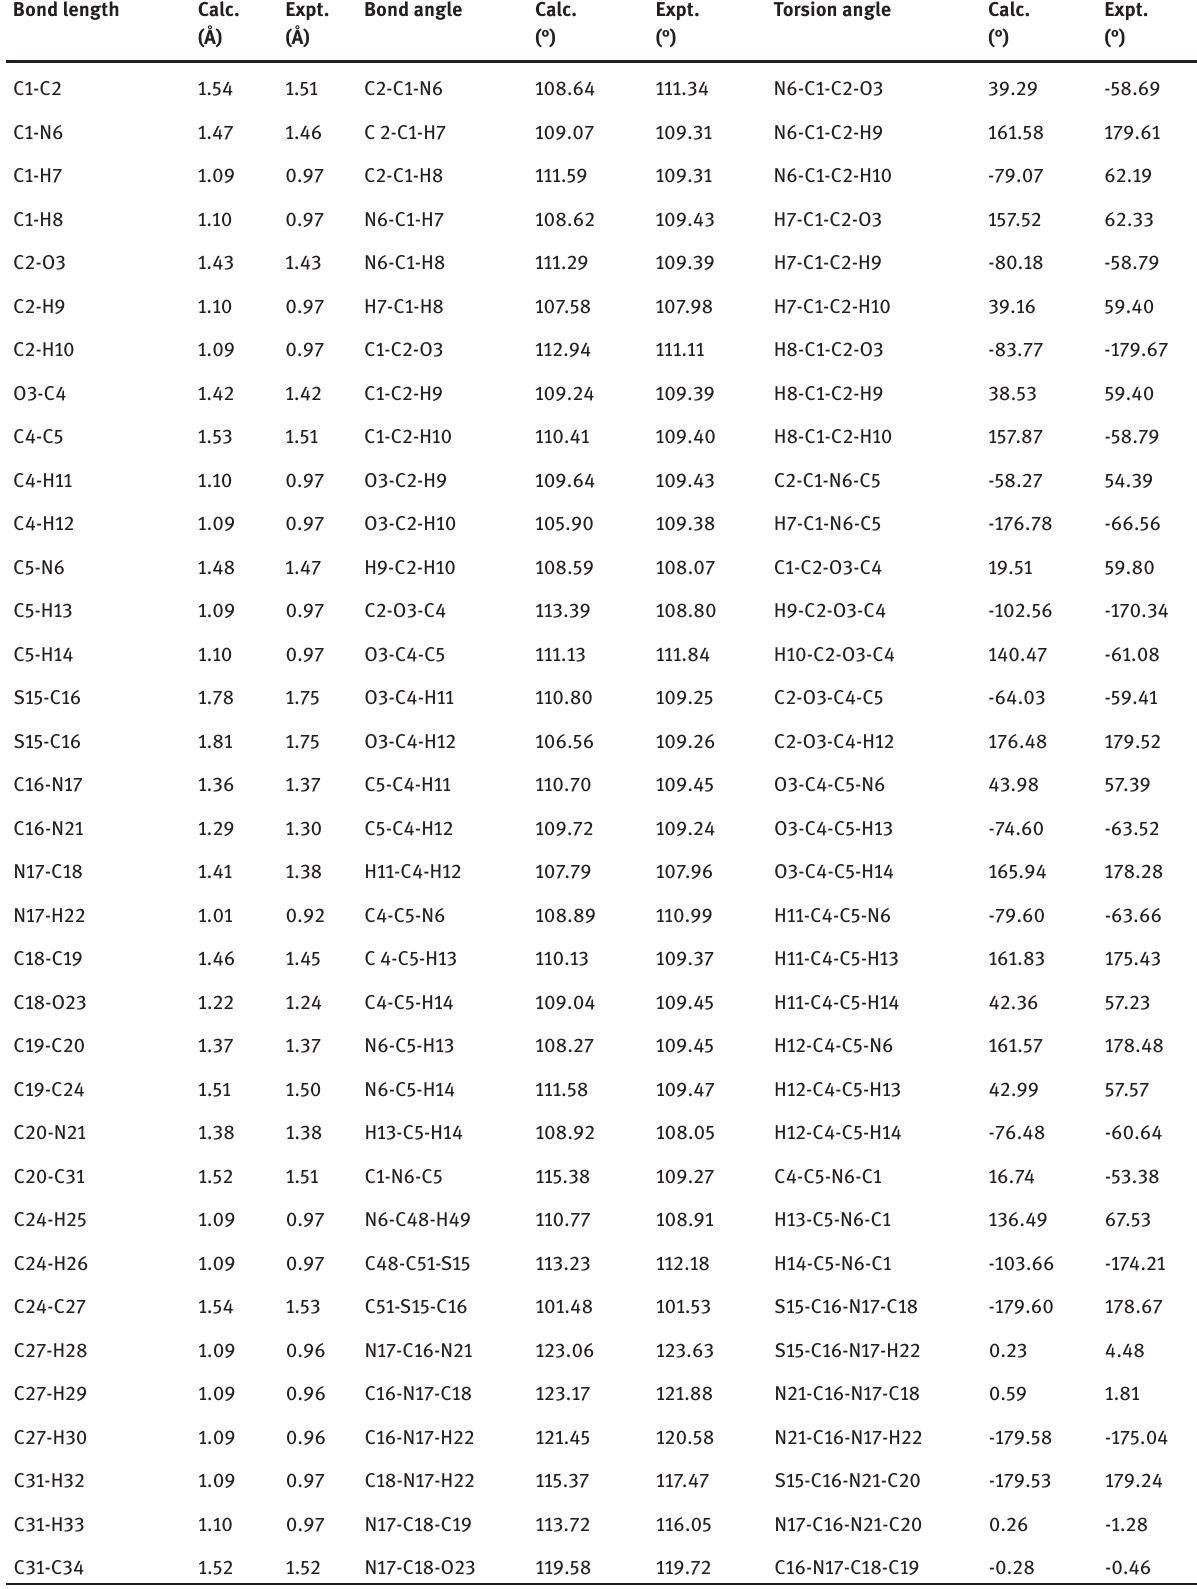
Table 1: The calculated optimized geometrical parameters of compound at B3LYP/6-311++G(d,p) level of basis set. Bond